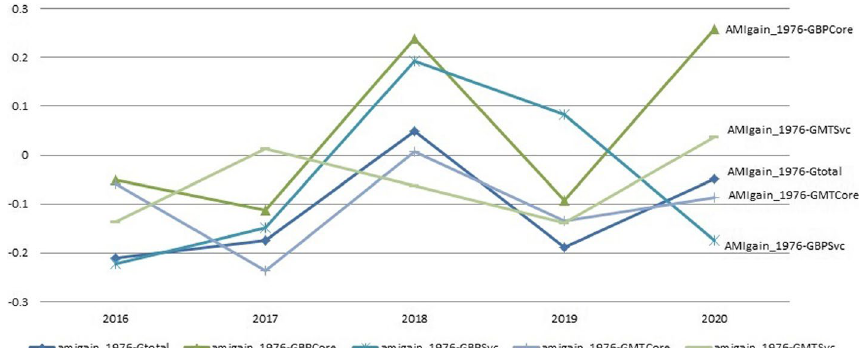
Fig. 1 Correlations between AMI Gain (from 1976 to 2014) and Annual Firm Numbers and Growths by